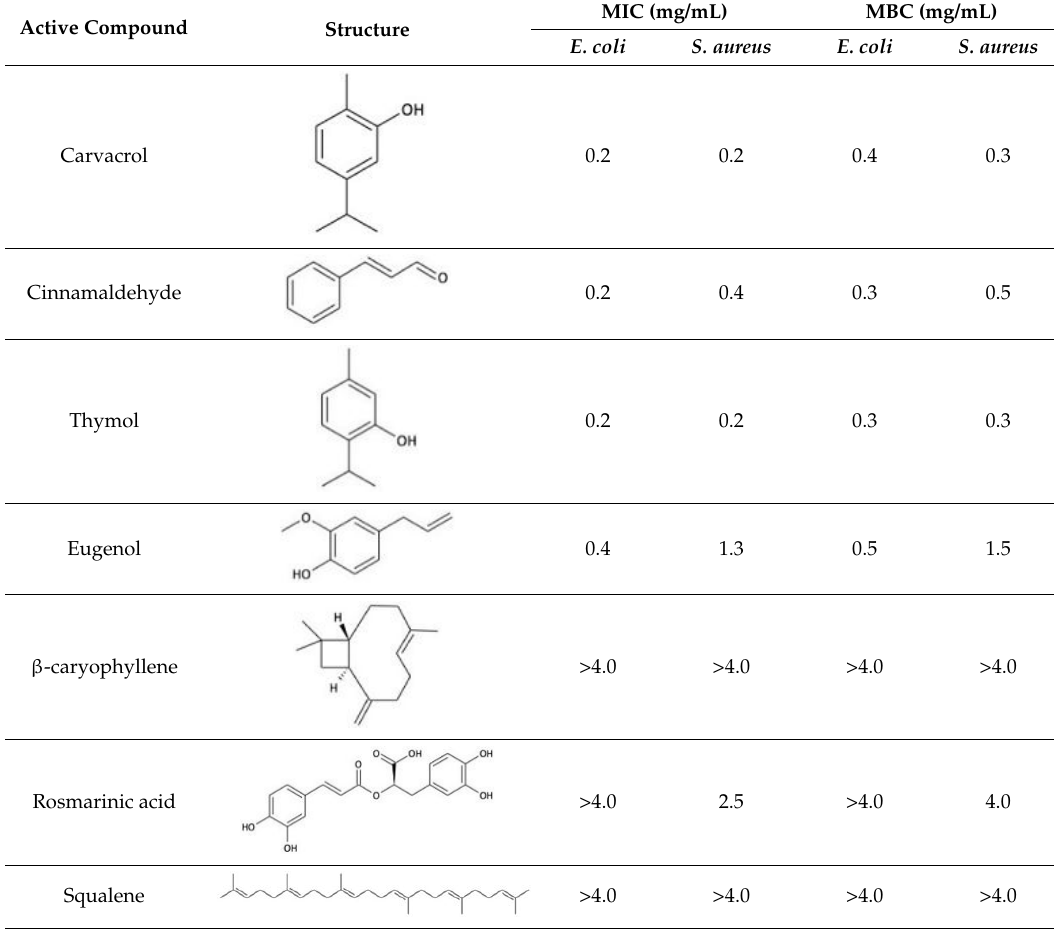
Table 1. Chemical structure and minimal inhibitory concentration (MIC) and minimal bactericidal concentration (MBC) values of different essential oil contained compounds. Average of 12 replicas each